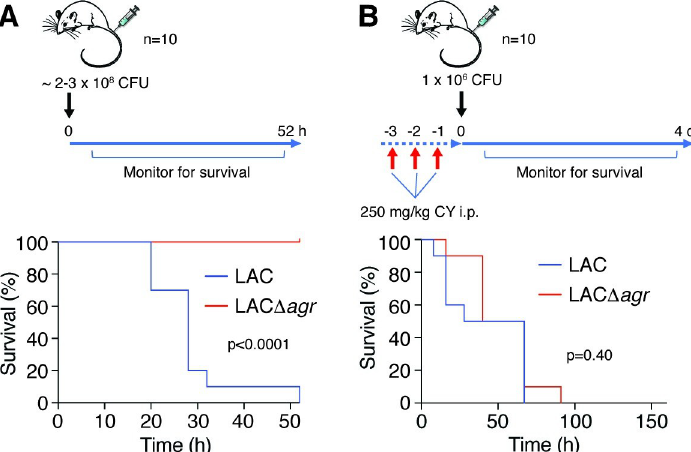
Fig 1. Mouse sepsis model. ( A ) Scheme of experimental setup and survival experiment. Survival of female C57BL/ 6NCrl mice following intravenous challenge with ~2–3 × 10 8 CFU of S . aureus LAC or its isogenic agr deletion strain (n = 10/group) was recorded. Animals were monitored for survival up to 52 hours. Statistical analysis is by log-rank (Mantel-Cox) test. ( B ) Survival experiment under cyclophosphamide (CY) treatment. Scheme of experimental setup and survival data. Survival of female C57BL/6NCrl mice following intravenous challenge with 10 6 CFU of S . aureus LAC or its isogenic Δ agr deletion strain (n = 10/group) was recorded. Statistical analysis is by log-rank (Mantel-Cox) test. Mouse picture is from